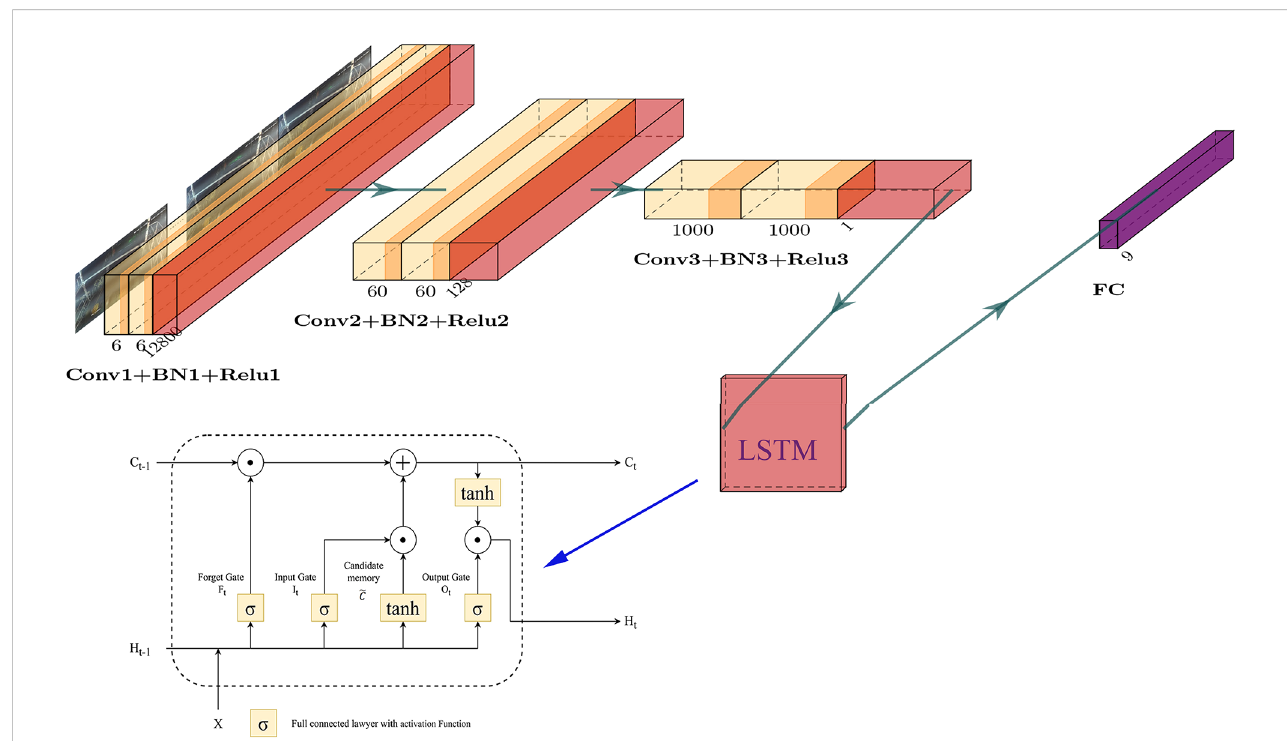
FIGURE 6 The structure of the LSTM module and the position of the LSTM module in the